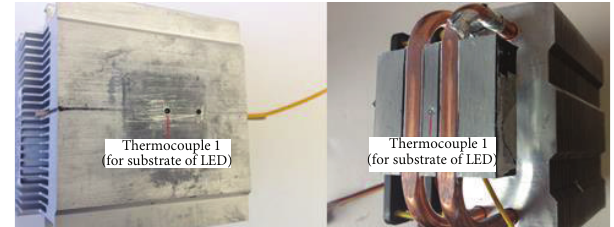
Figure 5: Thermocouple 1 for used temperature substrate of LED.